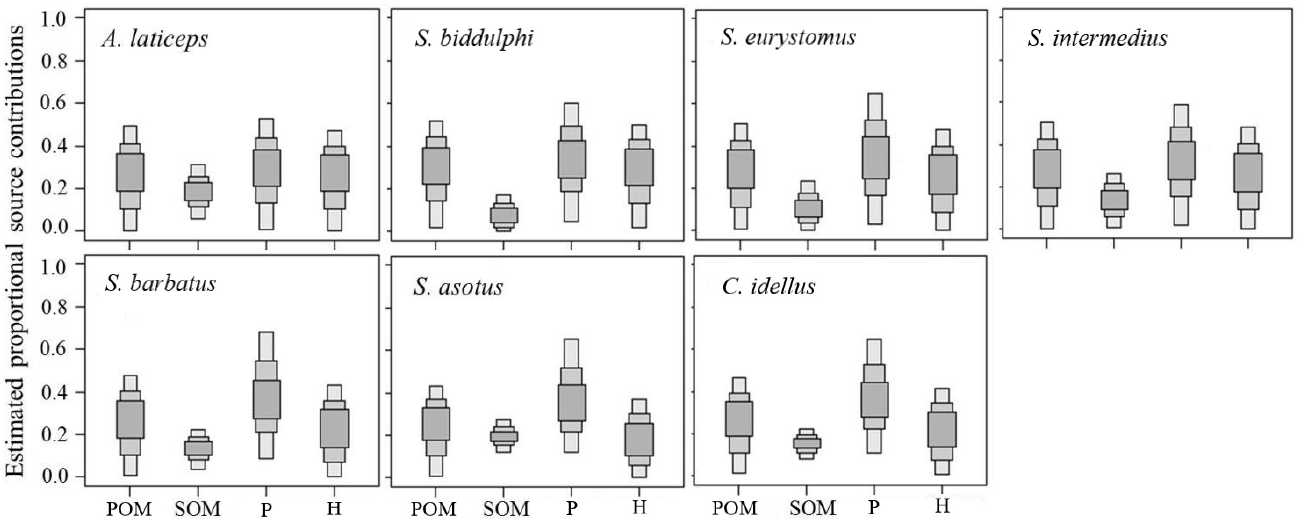
Figure 3. Estimated proportional source contributions (with 50%, 75% and 95% credibility intervals; POM: particulate organic matter, SOM: soil organic matter, P: phytoplankton and microphytobenthos, H: hygrophyt) as determined by SIAR [42] for five native schizothorax fish ( A. laticeps , S. biddulphi , S. eurystomus , S. intermedius , S. barbatus ) and two invasive fish ( S. asotus, C.idellus ).